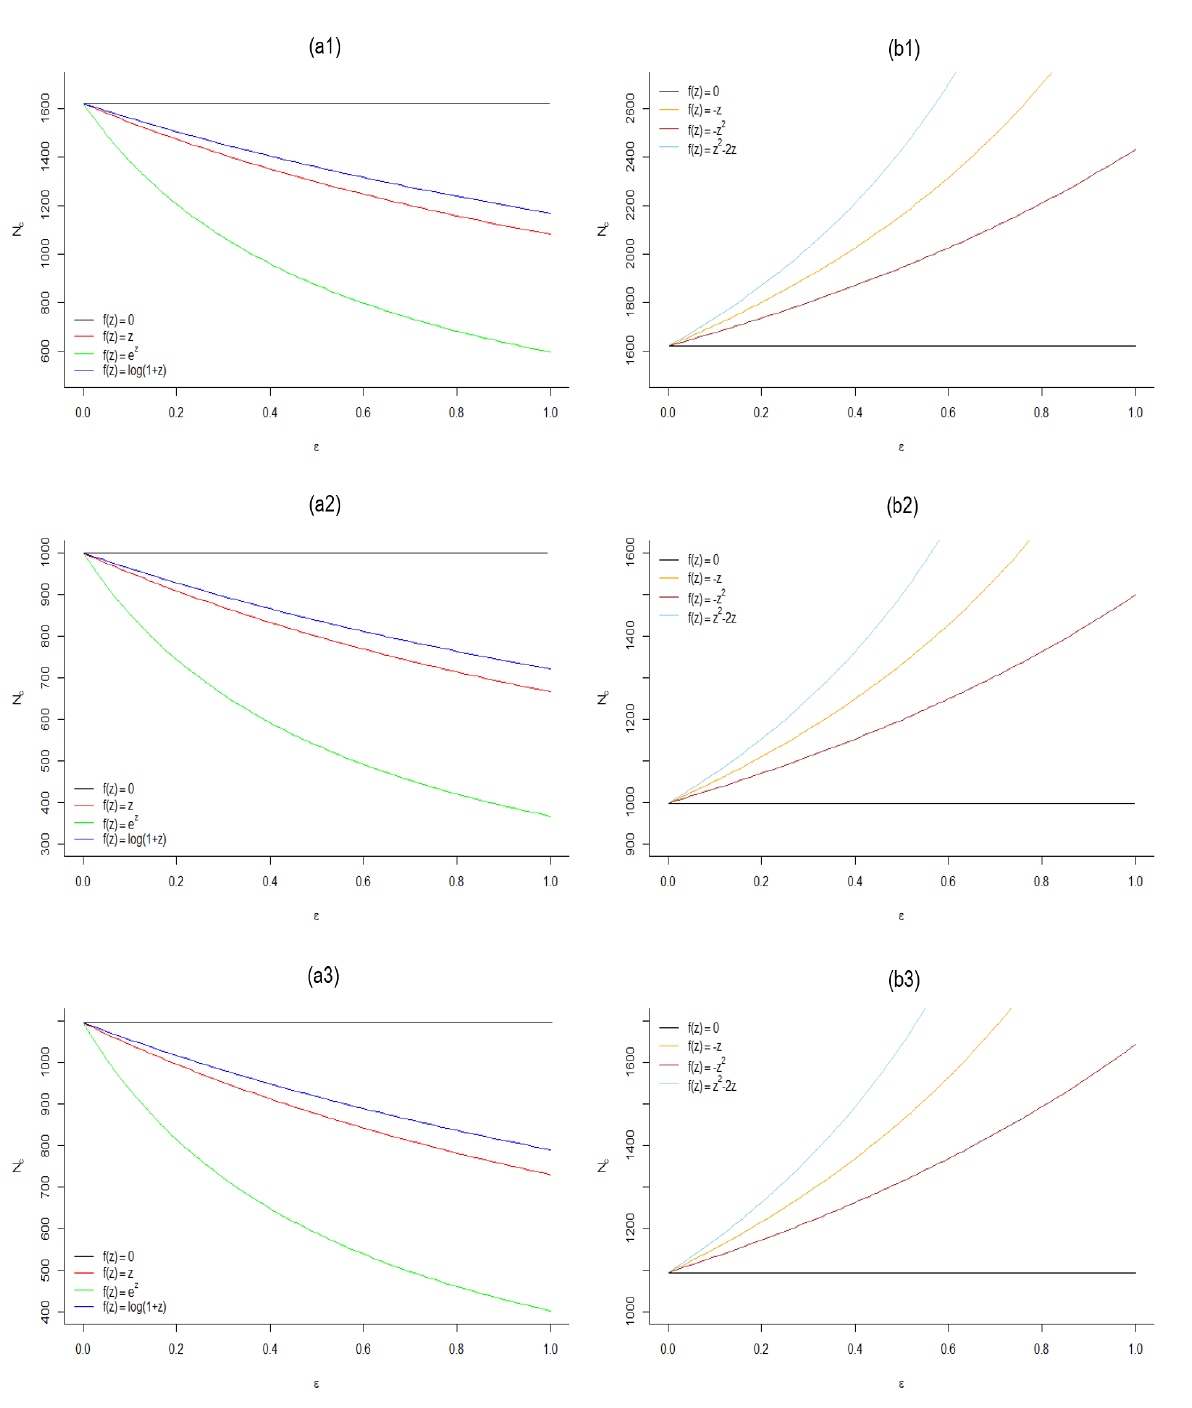
Figure 5. For different changeable gravity functions, relationship between N c and (cid:101) , for δ = 0.08 and M 3 = 1 in ( a1 , b1 ), for δ = 0.08 and M 3 = 10 in ( a2 , b2 ), for δ = 0.08 and M 3 = 20 in ( a3 , b3